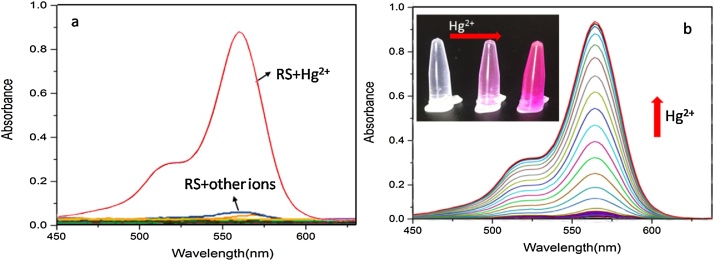
(a) UV–vis absorption spectra of the receptor RS (10 μM) observed upon the addition of 100 μM ions (Na+, Ag+, Ca2+,Mg2+, Cu2+, Zn2+, Cd2+, Ni2+, Mn2+,Fe2+, Cr6+, Fe3+, Pb2+and ClO4−) in CH3CN/H2O (5 :5, v/v). (b) UV–vis titration spectra of RS (10 μM) upon incremental addition of0 to 100 μM Hg2+ in CH3CN/H2O (5: 5, v/v). Inset picture: the color changes of RS to Hg2+.